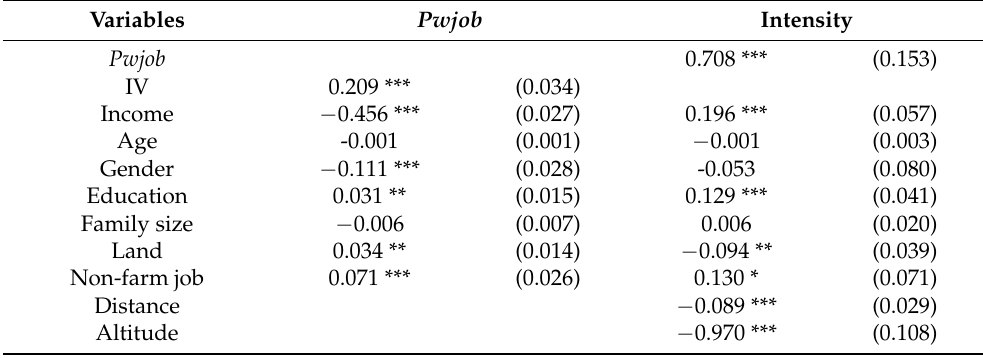
Table 5. The IV-oprobit regression